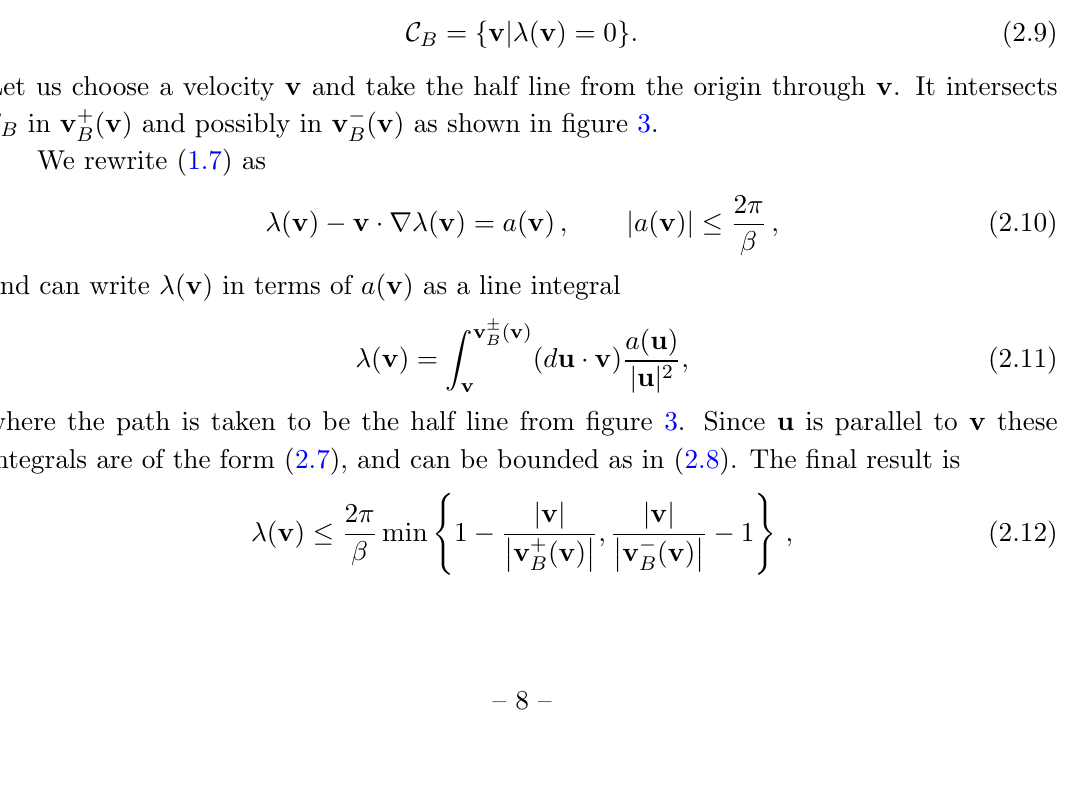
Figure 3 . De(cid:12)nition of v (cid:6) ( v ). The dashed half lines connect v with the origin, and their inter- B section with the shapes de(cid:12)ne v (cid:6) ( v ). For the green shape only v + B shape v + ( v ) is the farther and v (cid:0) ( v ) is the closer B B